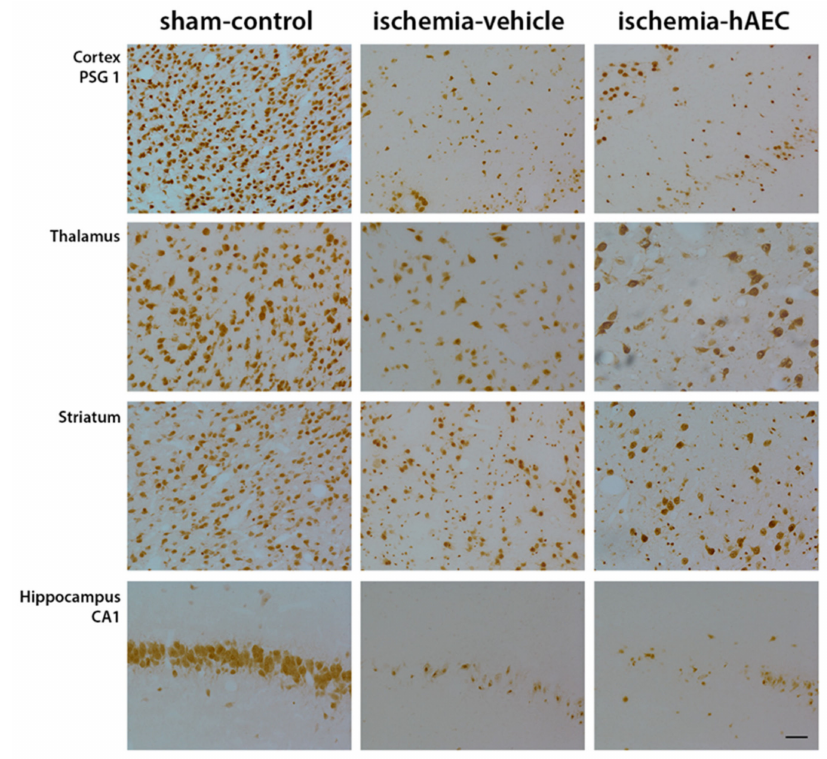
Figure 4. Photomicrographs showing representative NeuN-labelled images in the cortex, thalamus, striatum and CA1 of the hippocampus in the sham control, ischemia-vehicle and ischemia-hAEC groups. Scale bar is 50 µ m.